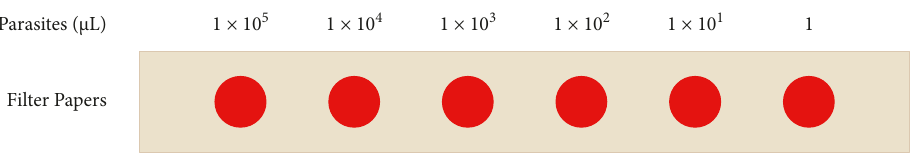
Figure 1: The scheme of the preparation of dried blood spot samples by tenfold serial diluting Plasmodium yoelii -infected